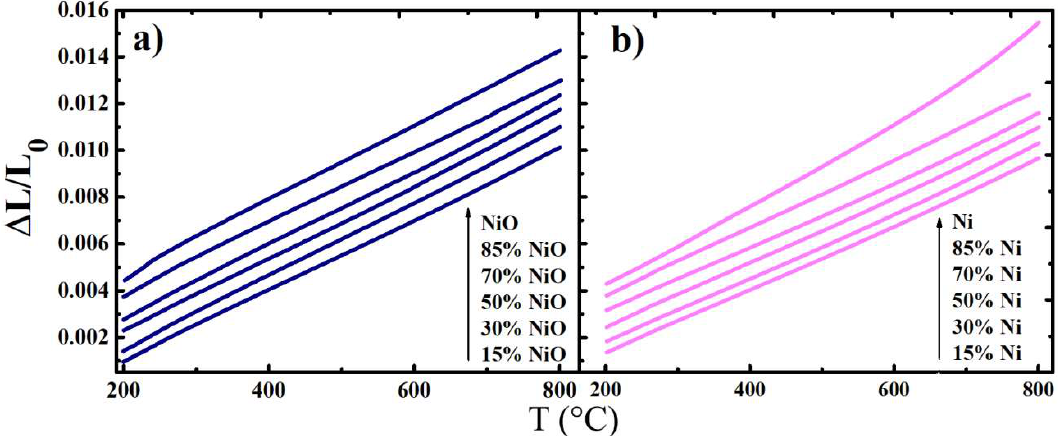
Figure 2. Thermal expansion curves of the (1–x)Sr 2 Mg 0.25 Ni 0.75 MoO 6–δ + xNiO composites and NiO oxide between 200 and 800 °C ( a ) in the air ( b ) in 50%H 2 /Ar